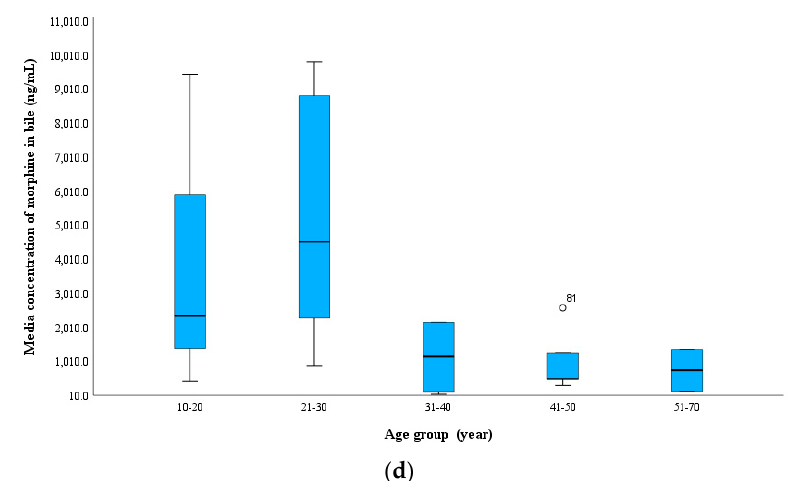
Figure 3. Variation of morphine concentration in the 97 heroin-related fatality cases according to age group ( a ) blood with sodium fluoride (ng/mL), ( b ) urine (ng/mL), ( c ) vitreous humor and ( d ) bile. The whiskers correspond to the smallest and largest value within 1.5 times the interquartile range, and circles (outlier) symbolize values exceeding at least 1.5 times the interquartile range and extremes (asterisks) correspond to values exceeding at least 3.0 times the interquartile range (this description is applied to the remaining box-plot figures).